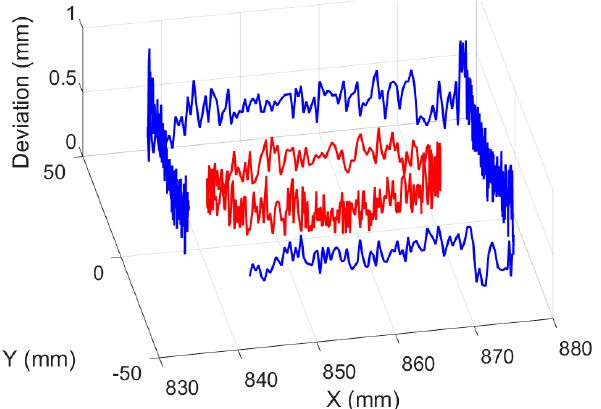
Figure 31. Experimental deburring results of target planning path and actual tool path of proximal side facet.